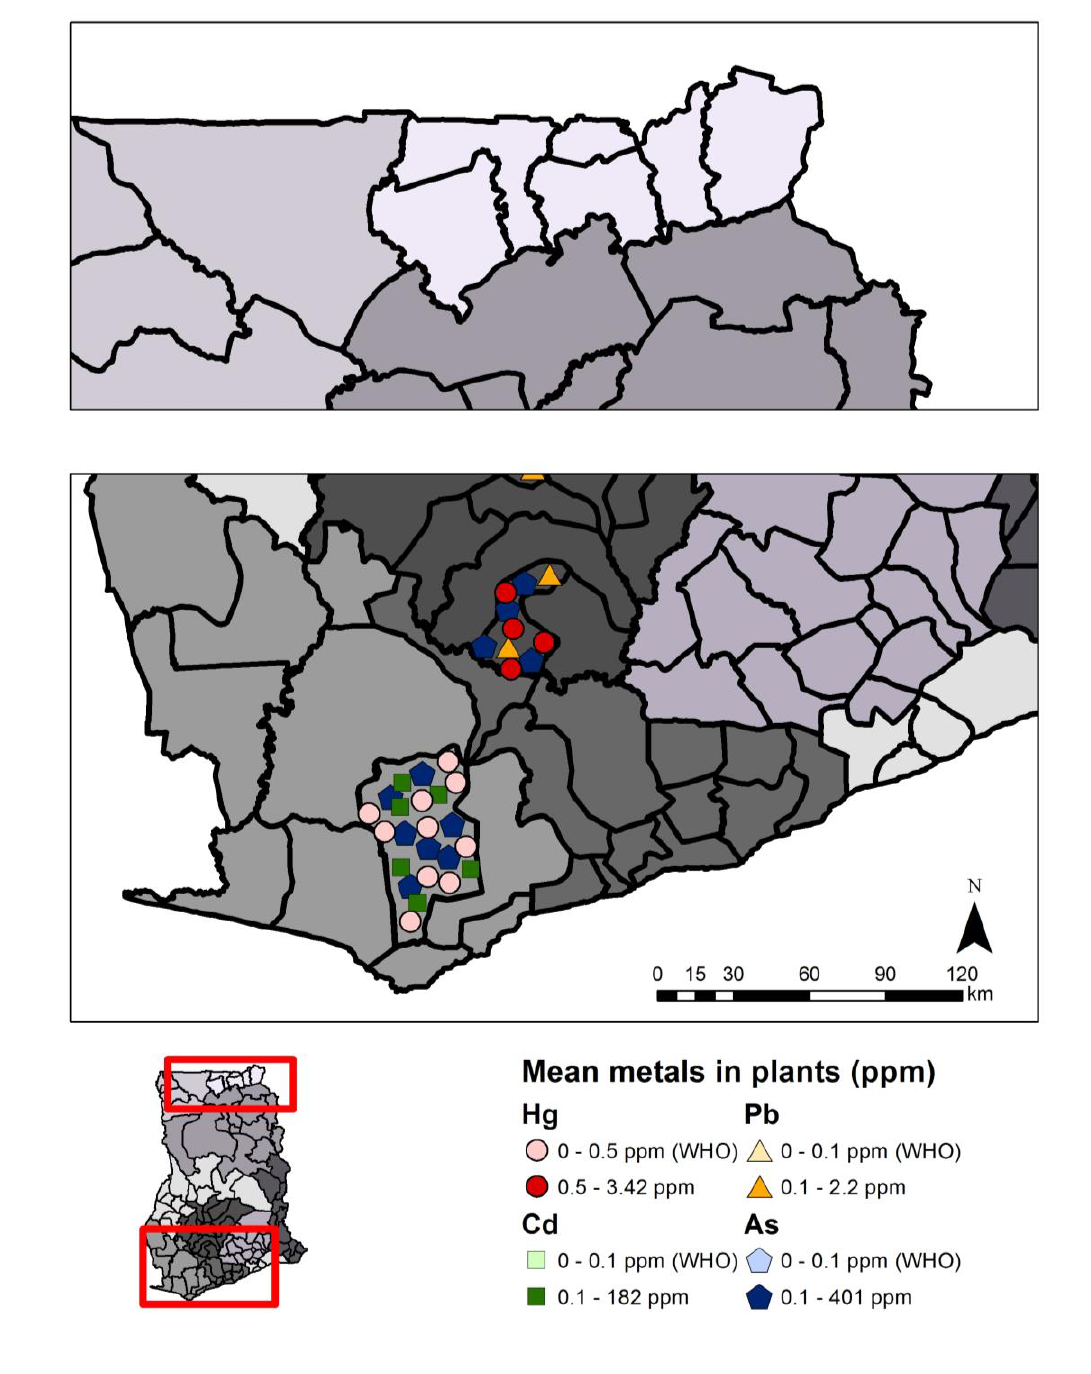
Figure 6. Metals in edible plant parts in southwest Ghana (bottom panel). Each symbol represents the mean metals value (µg/g or ppm) from a single study in that region, and for illustrative convenience the symbols are scattered randomly within the district where the sampling took place. Political regions are distinguished by different shades of grey. Mean total mercury (Hg), lead (Pb), cadmium (Cd), or arsenic (As) above or below guidelines are indicated. Plants sampled include cassava ( Manihot esculenta ), cocoyam ( Xanthosoma sagittifolium ), water cocoyam ( Colocasia esculenta ), plantain ( Musa paradisiacal ), and water fern ( Ceratopteris cornuta ) grown in or around current or former ASGM